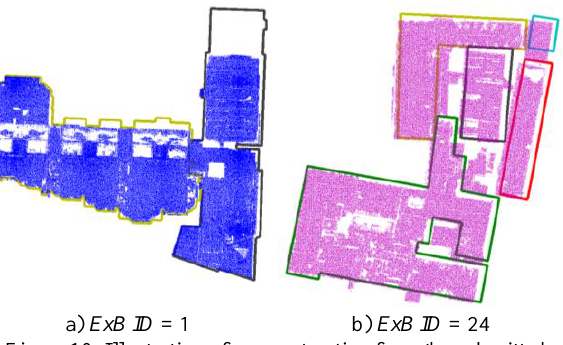
Figure 10. Illustration of over extraction from the submitted